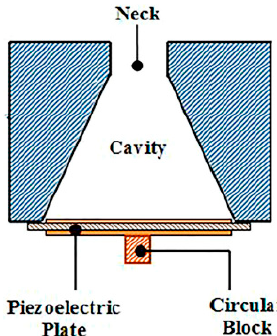
Figure 36. Helmholtz cavity-based AEHS with piezoelectric EH transduction [197].